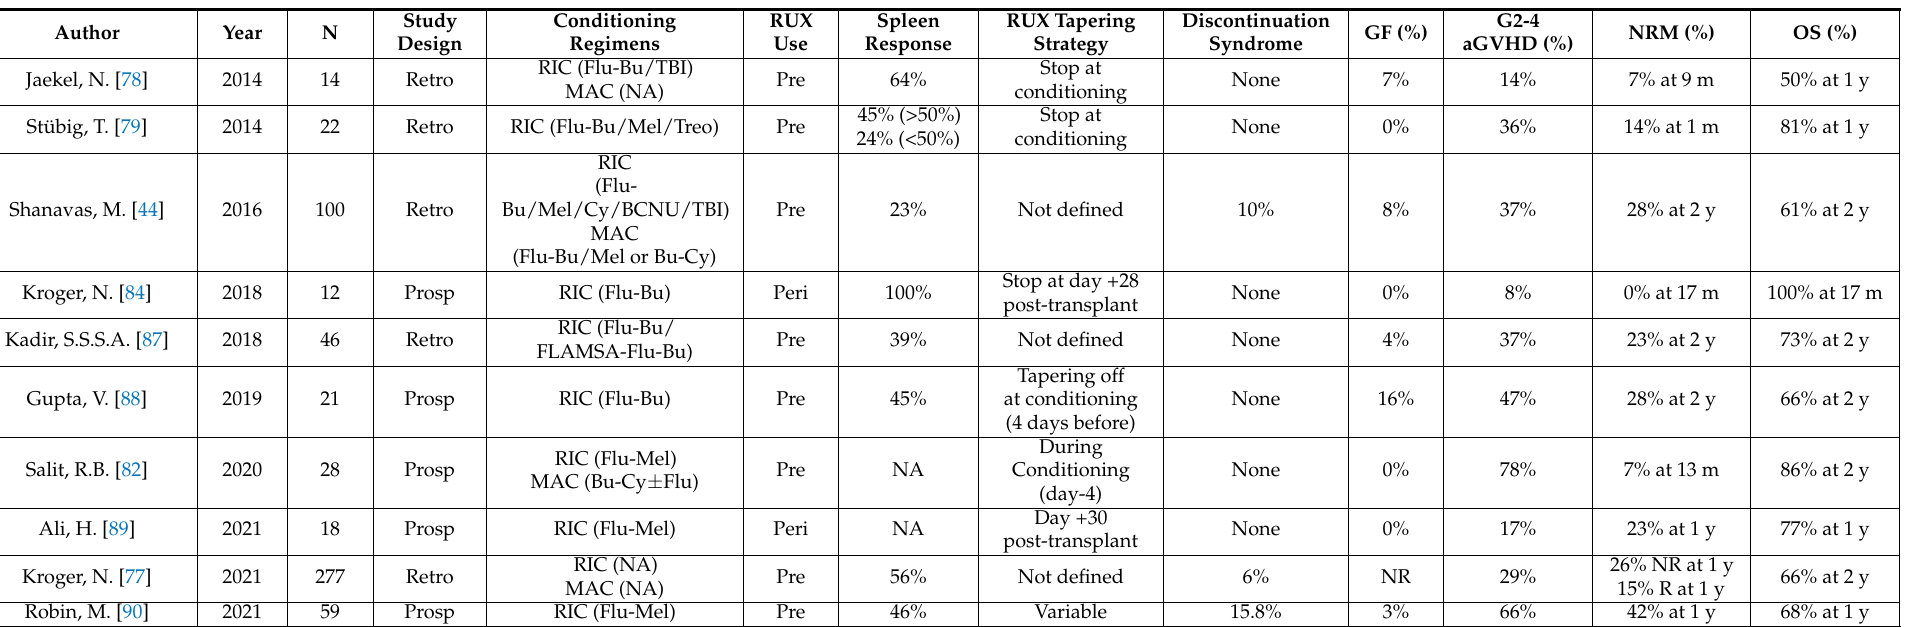
Table 2. List of studies investigating the role of ruxolitinib (RUX) in the pre- or peri-transplant